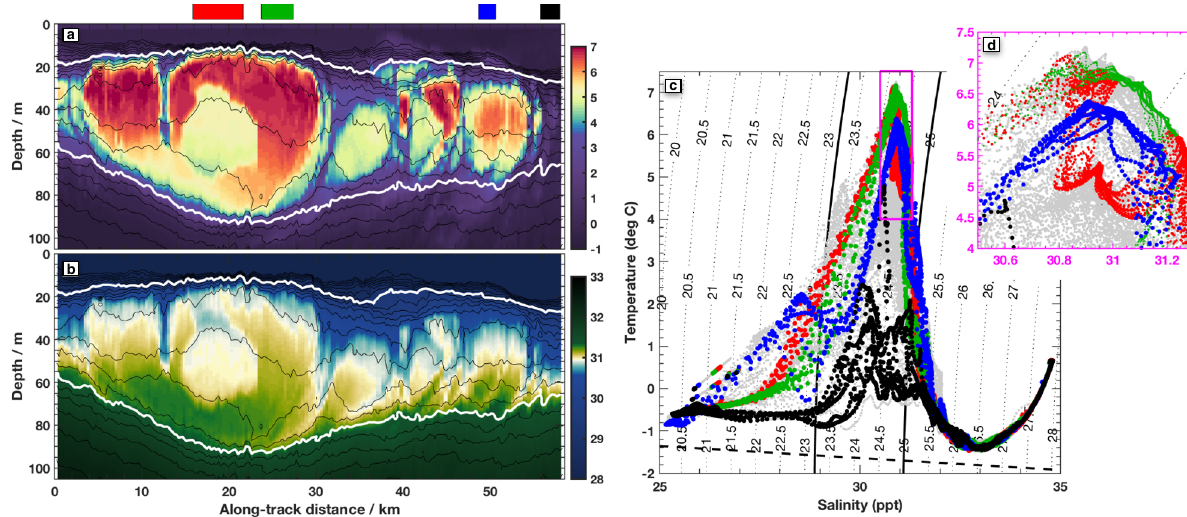
Fig. 5 Results from a FastCTD survey on 24 Sept, 9 days after the original measurements. The survey track is shown in Fig. 1c (purple dotted), and took 7 h to complete. a , b Temperature and salinity sections, as in Fig. 2. The four colored blocks above indicate the subsets regions periods used for subsequent panels. c Temperature-salinity measurements as in Fig. 3 for all data in this section (gray) and the four sub-regions indicated with color. d Expanded view of the portion of the T-S plot indicated with a magenta box in c